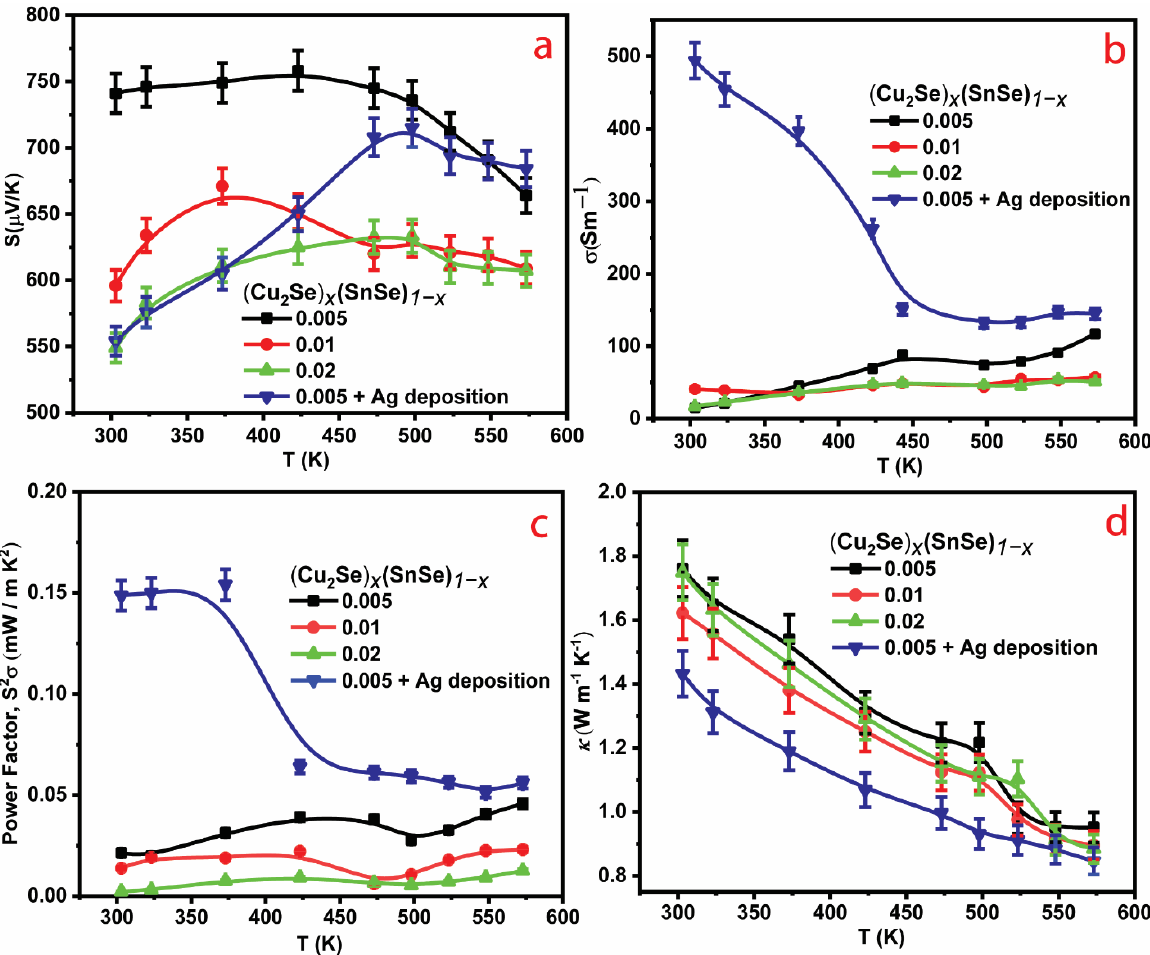
Figure 2. Temperature-dependent ( a ) Seebeck coefficient, S , ( b ) electrical conductivity, σ , ( c ) power factor, S 2 σ , ( d ) thermal conductivity, κ of (Cu 2 Se) x (SnSe) 1 − x +Ag ( x = 0.005, 0.01, and 0.02) alloys.